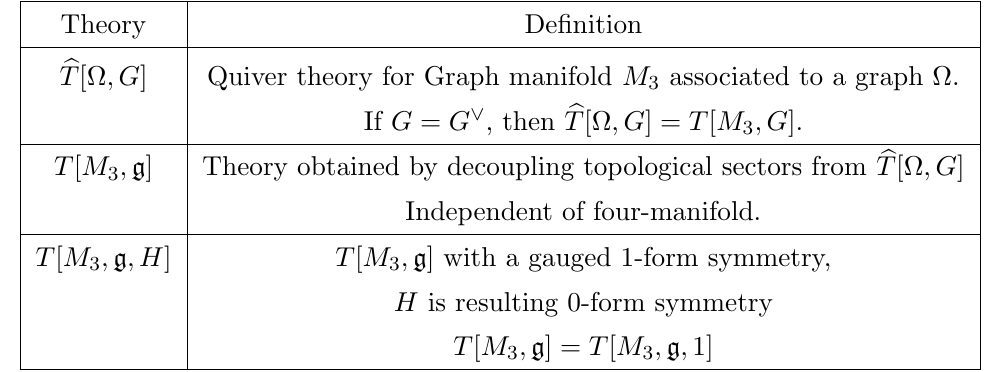
Table 1 . Summary of the theories de(cid:12)ned in this paper. The theories can be de(cid:12)ned for both N = 2 and N = 1 preserving compacti(cid:12)cations of the 6d (2 ; 0) theory. 2. The graph (cid:10) representing M is not unique. Instead, it represents a four-manifold 3 M with boundary M . There are various operations that leave M 4 3 invariant but change (cid:10). We can check that b T [(cid:10) ; G ] is only invariant under these operations up to decoupled topological sectors